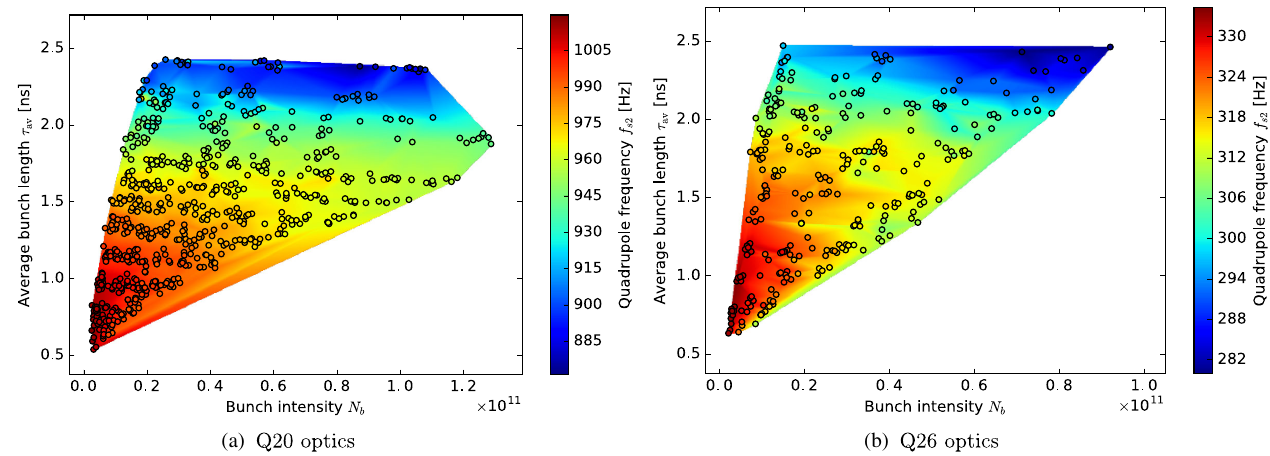
FIG. 12. Measured quadrupole frequency f s 2 as a function of bunch length and intensity in both Q20 (left) and Q26 (right) optics. Each point corresponds to a single measurement, and the colored surface corresponds to the quadrupole frequency (gaps were filled using interpolation).